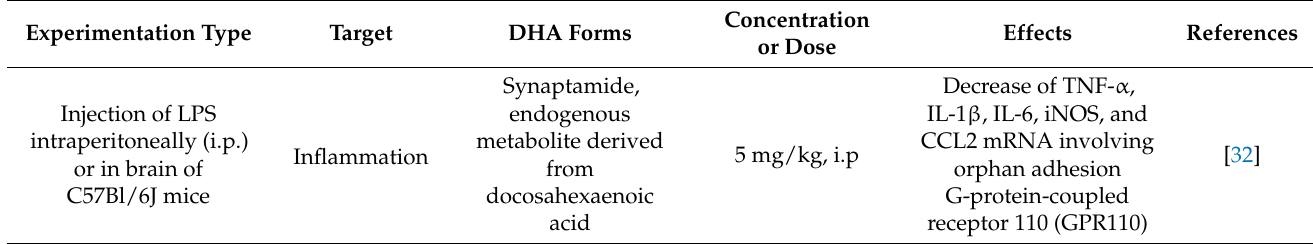
Table 2. In vivo data on the effect of